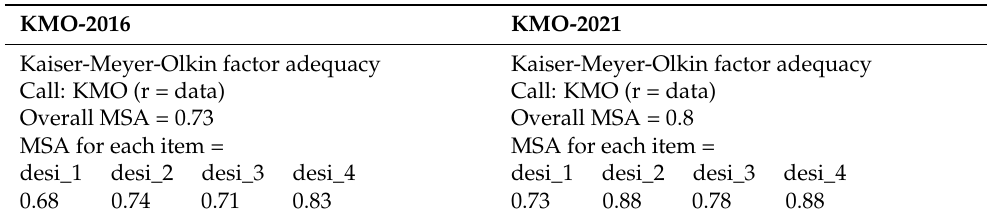
Table 4. Kaiser–Meyer–Olkin test on DESI main indicators in 2016 and